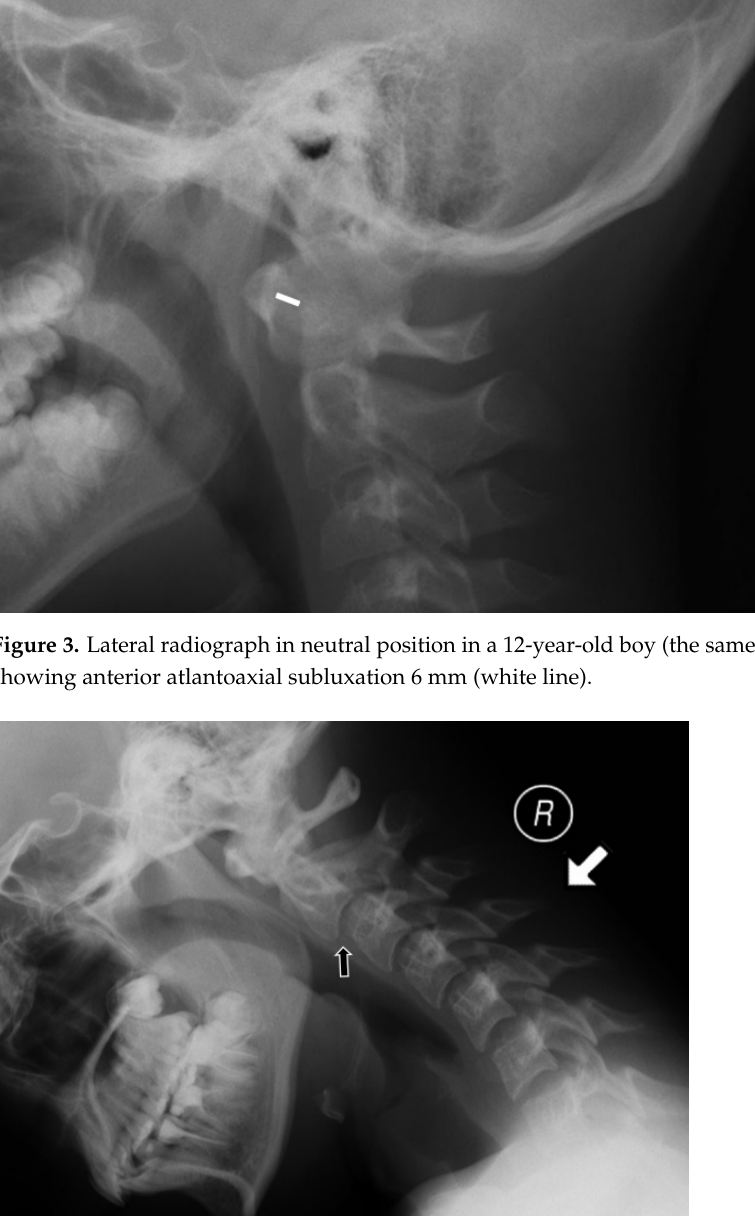
Figure 4. Lateral radiograph in flexion (indicated by white arrow) in a 13-year-old girl showing subaxial subluxation at C2/C3 level (black arrow).